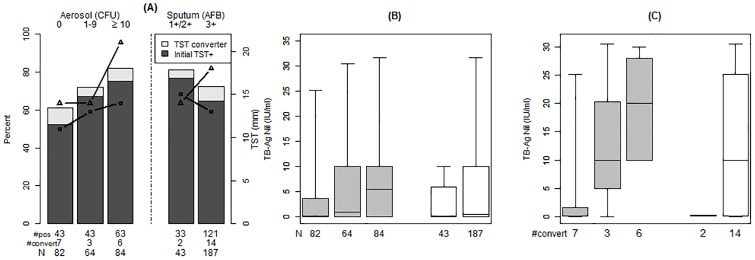
TST and IGRA results in 230 household contacts of TB patient according to the number of CFU of M. tuberculosis in cough-generated aerosols or AFB smear microscopy in the index TB case.(A) Histograms represent the proportion of contacts with a TST ≥10mm at baseline (black) and those with TST conversion (grey). The solid line represents the median TST diameter (mm) for contacts with TST ≥10mm at baseline (circles) and maximum TST for those with TST conversion (triangles) for each exposure group. (B) Standard box plots of maximum IGRA readouts in contacts of smear + culture + TB cases. P = 0.08 for aerosol CFU, p = 0.26 for AFB sputum smear (C) Standard box plots of IGRA readouts in contacts with TST conversion. P = 0.02 for aerosol CFU, p = 0.33 for AFB sputum smear.